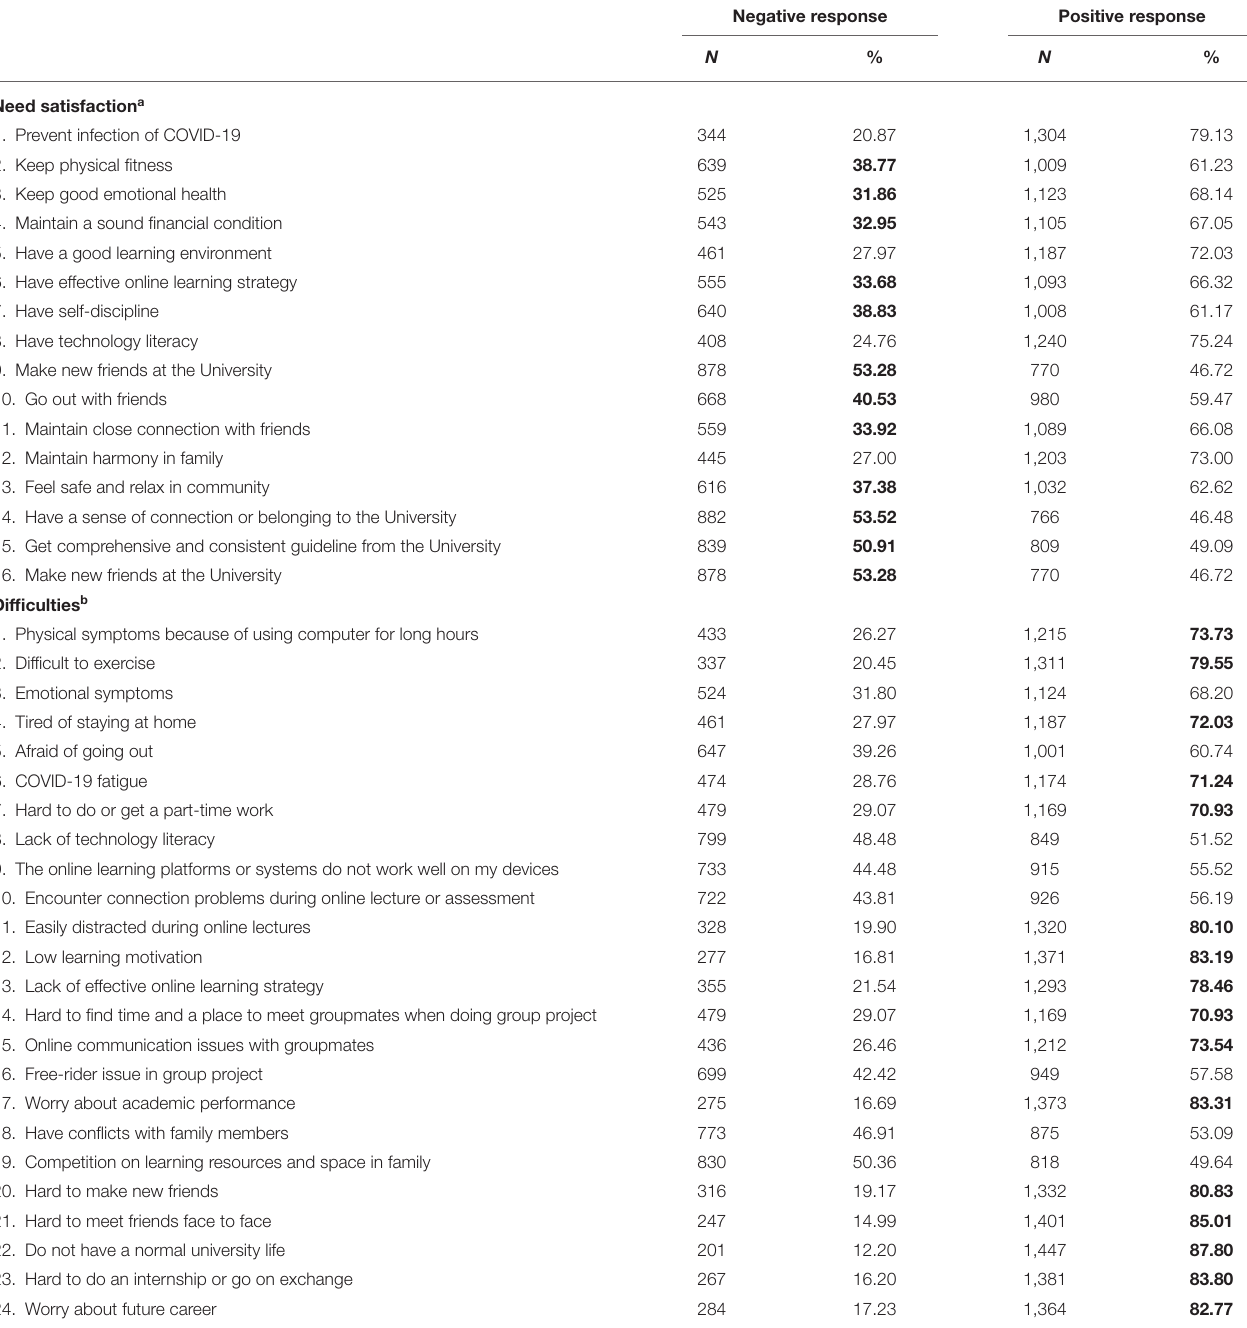
TABLE 4 | Response profiles of need satisfaction and